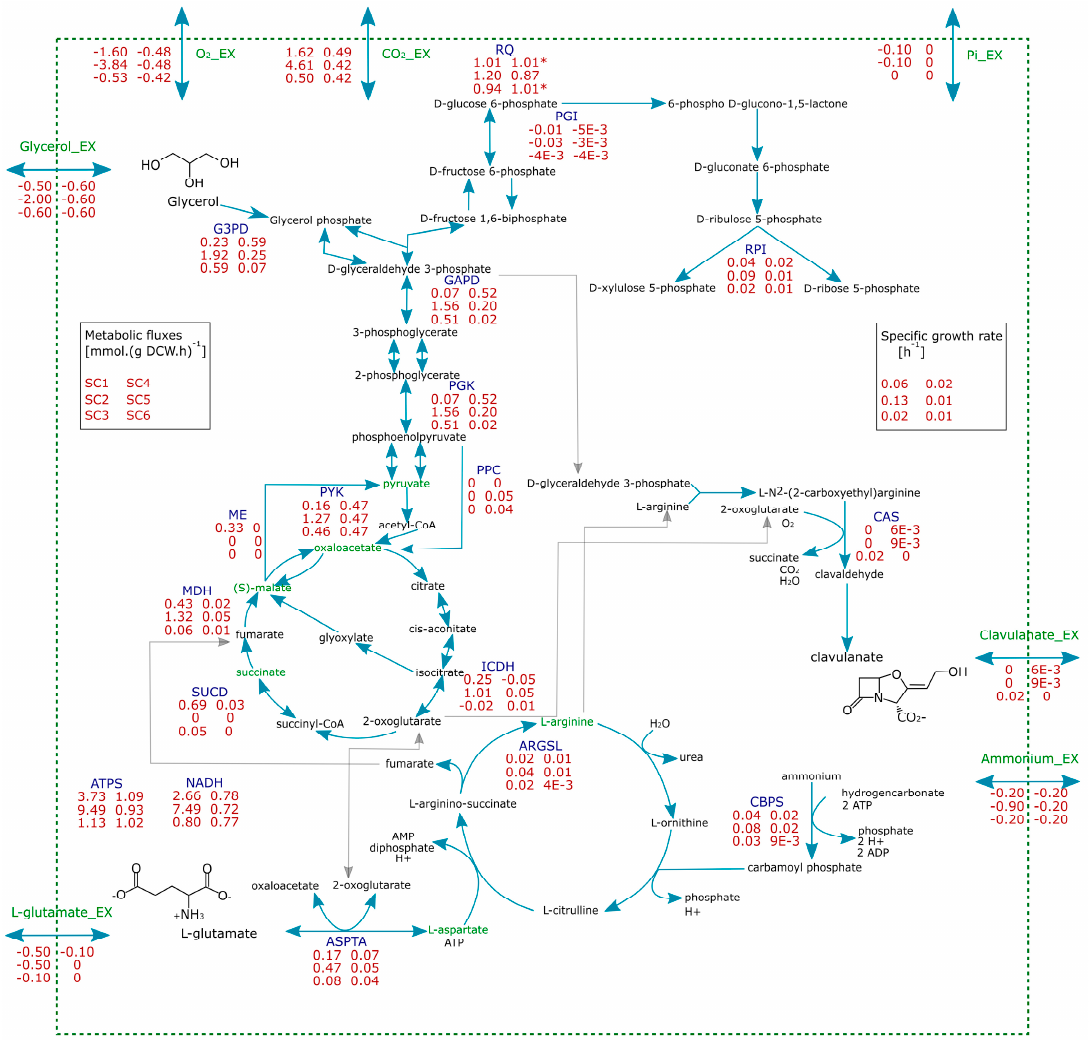
Figure 3. Summary of in silico carbon flux distribution throughout central metabolism and CA biosynthesis for S clavuligerus for the metabolic scenarios SC1–SC6. Substances in green were assayed and/or accumulated during the HSS and LSS cultivations.